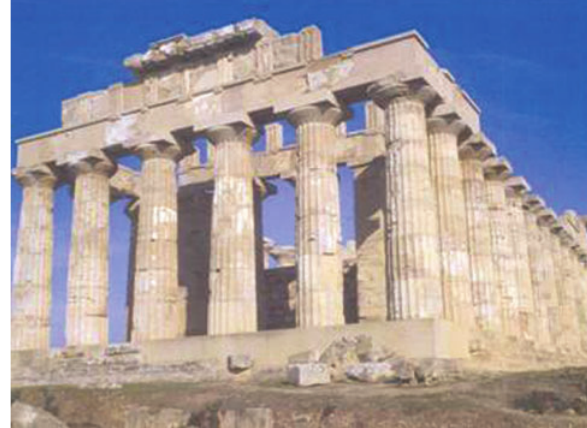
Figure 2 The reconstructed temple E, at Selinus (Sicily, Italy). The use of cement for the replacement of missing parts and reparation of damaged surfaces can be clearly seen.